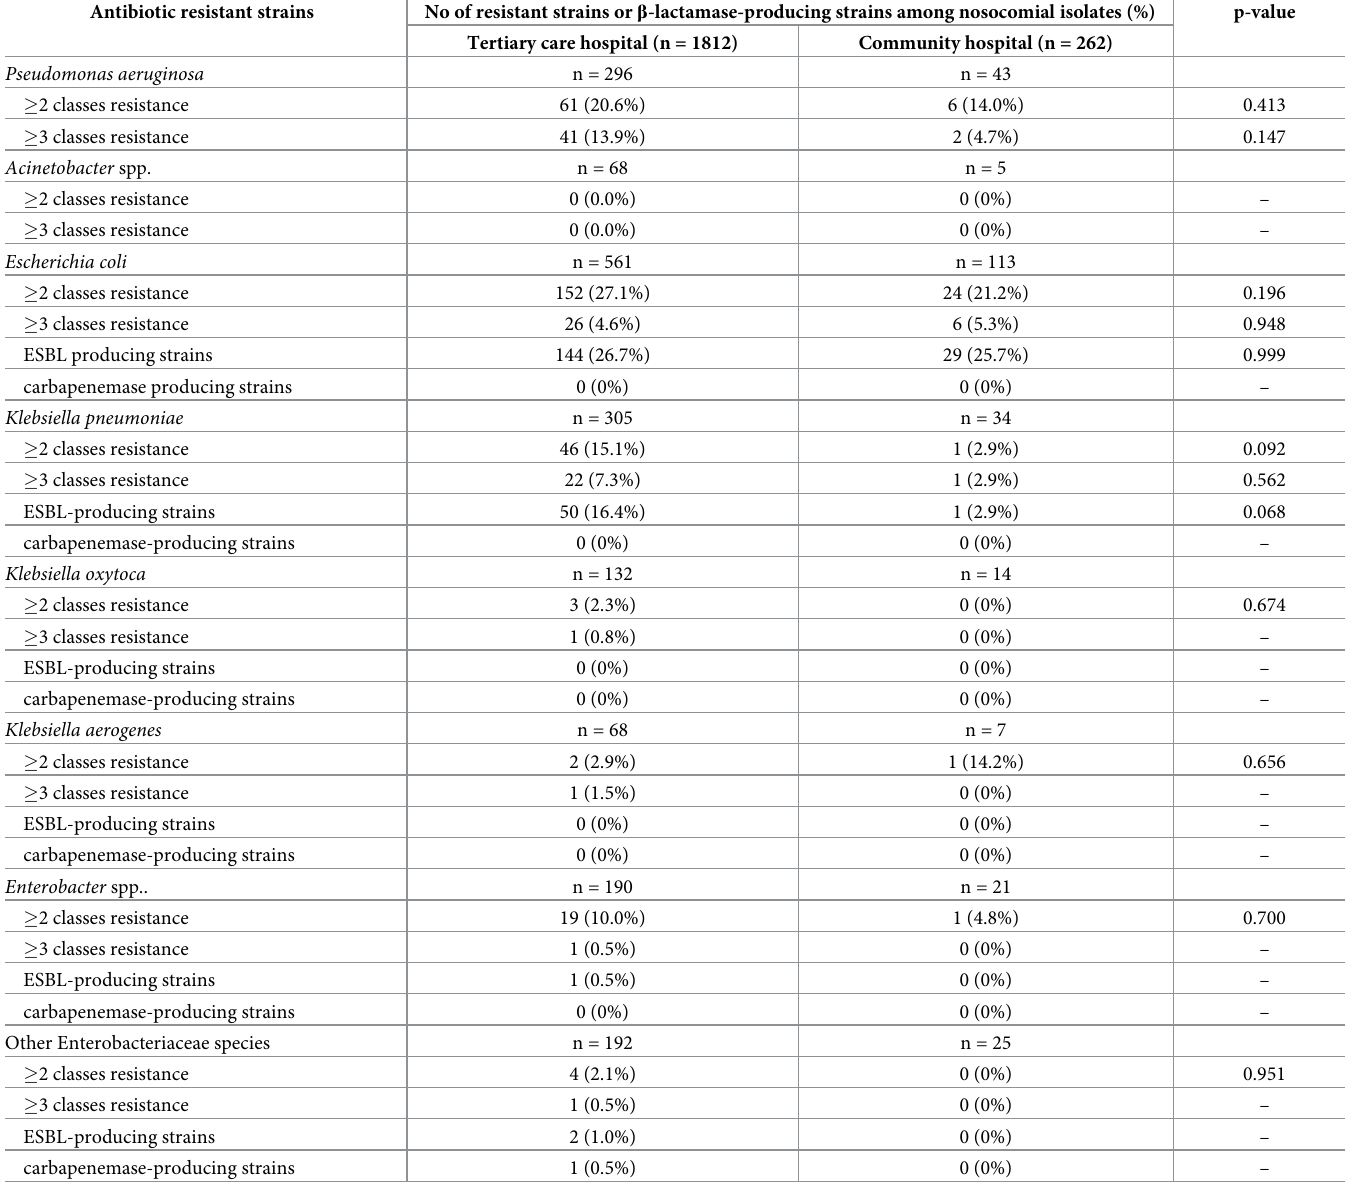
Table 3. Resistant rate according to the European Committee on Antimicrobial Susceptibility Testing criteria and beta-lactamase-producing rate in each organism in the tertiary care hospital and community hospital. Antibiotic resistant